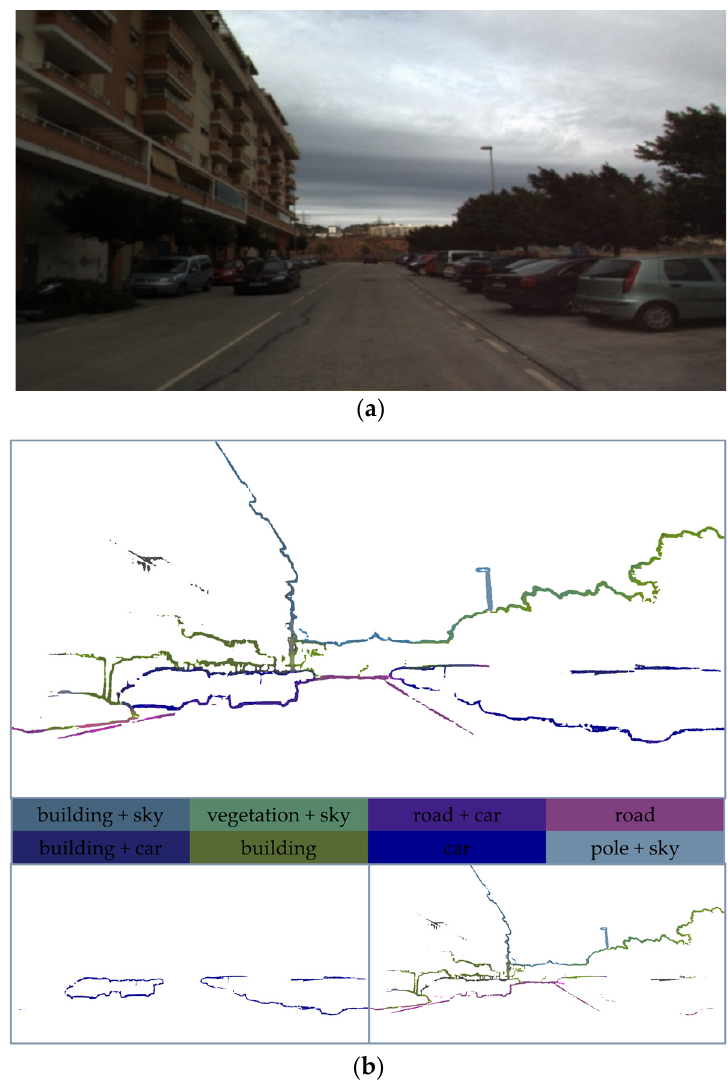
Figure 3. Visualization of semantic edge features. ( a ) raw image. ( b ) semantic edge images of all categories (above), dynamic categories (bottom left) and static categories (bottom right).